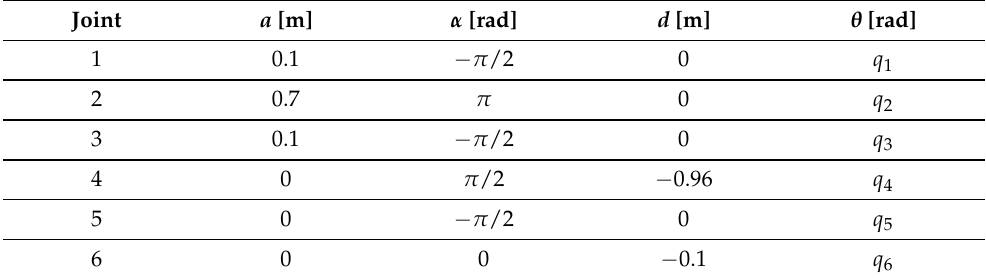
Table 4. DH table for KUKA Youbot